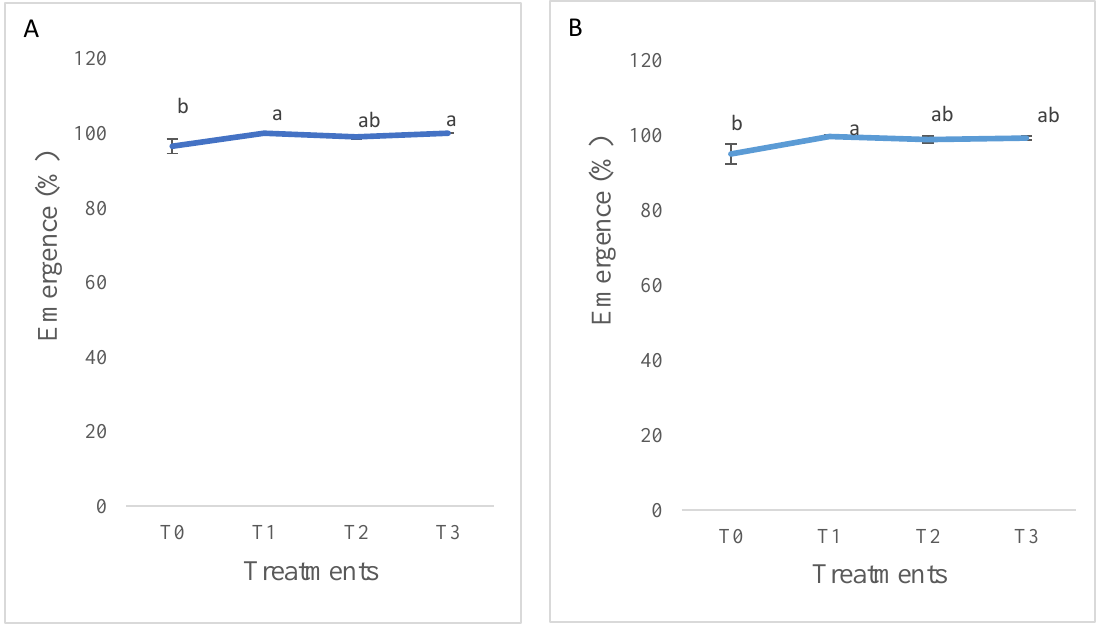
Figure 1. Rate of lucerne emergence under inoculation with liquid formulation (T0, T1, T2, and T3) of Sinorhizobium meliloti in climatic zone ( A ) = Bronkhorspruit/Gauteng and ( B ) = Hartbeesfoein/Northwest Province). Bars sharing a letter are not significantly different (Lsd Zone A) = 2.940 and (Lsd Zone B) = 4.286. Data are means ± standard errors.